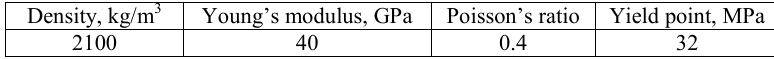
Table 2. Physical-mechanical properties of carbon.